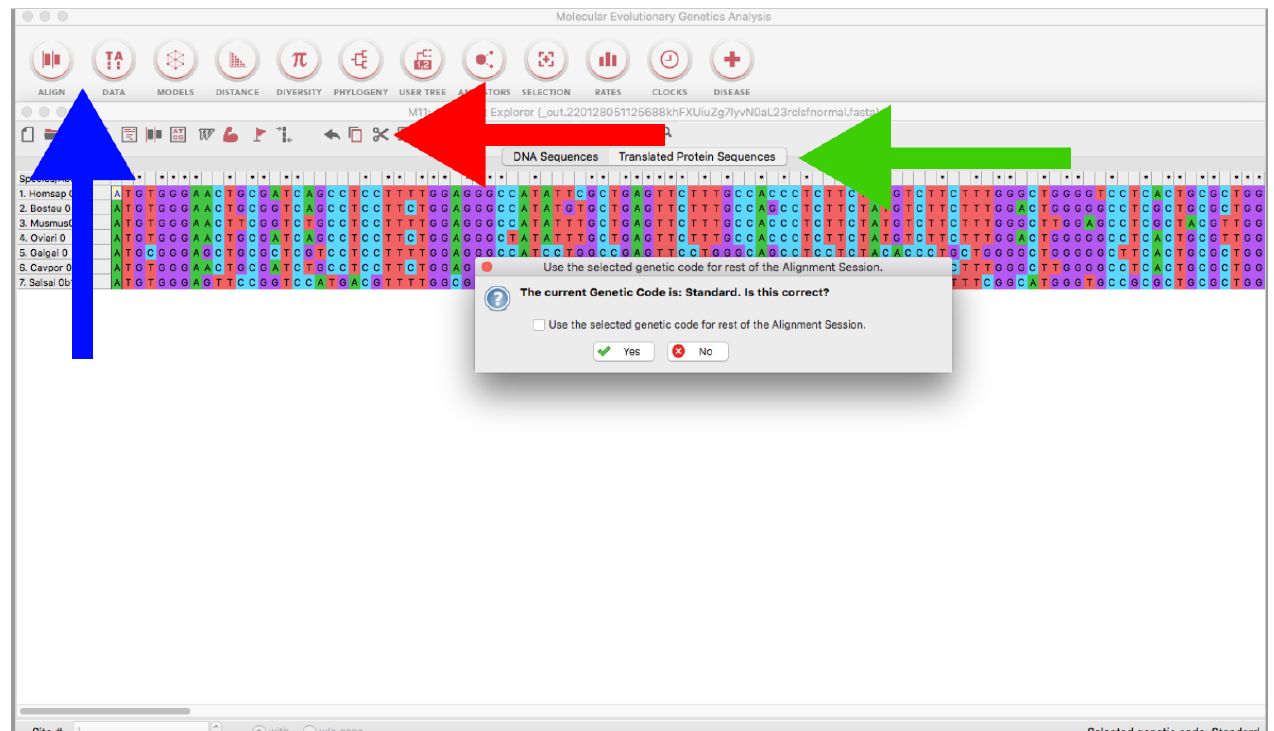
Figure 10. MEGA version 11 program showing a nucleotide alignment window. The blue arrow indicates the tool bar where the ALIGN and DATA buttons are located. The red arrow indicates the scissors tool. The green arrow indicates the Translated sequences tab.